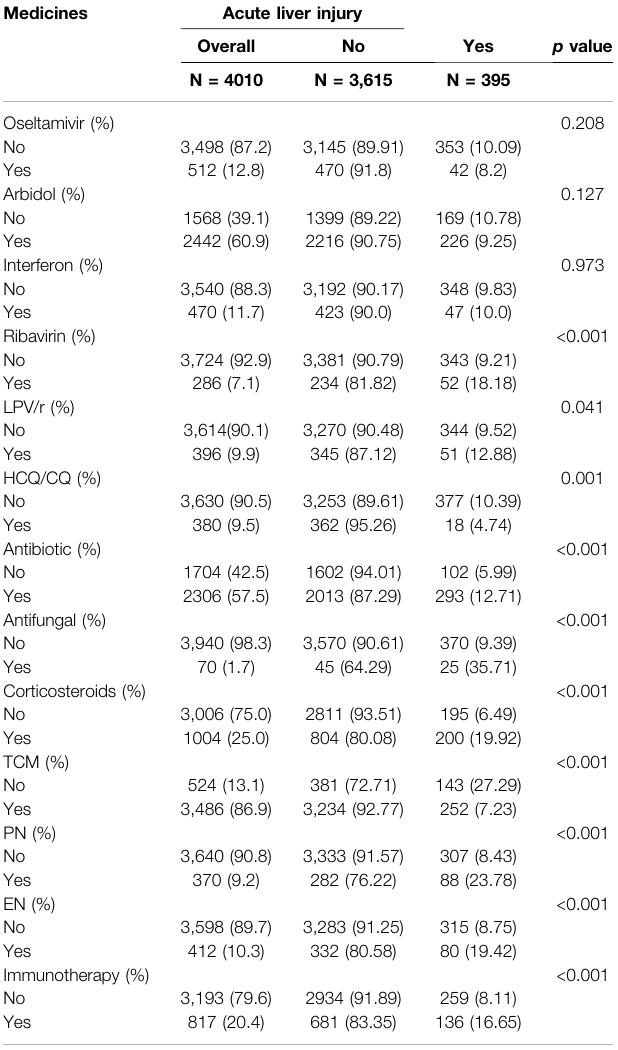
TABLE 2 | Medication for 4010 patients with COVID-19 during hospitalization.